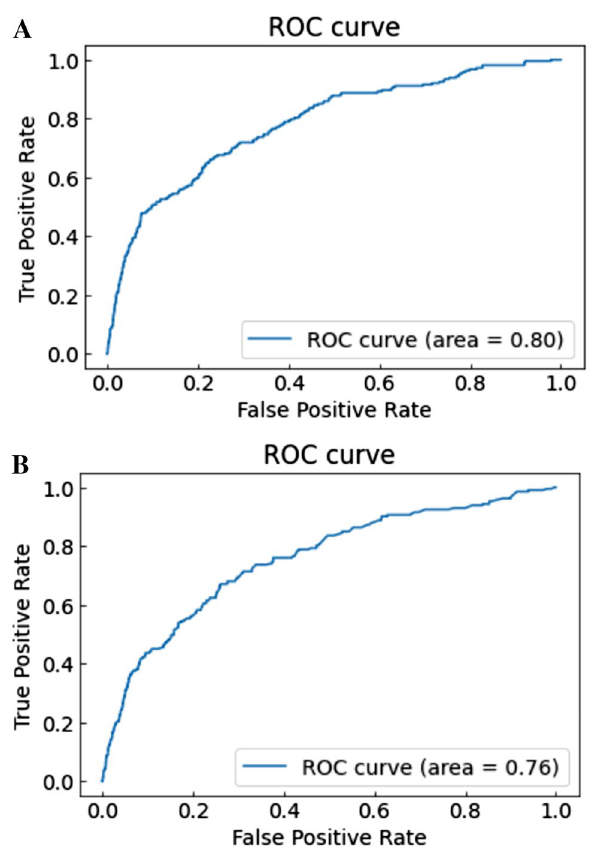
Figure 5. ( A ) ROC curve with training datasets using the logistic regression model with the 12 NCDR variables. ( B ) ROC curve with testing datasets using the logistic regression model with the 12 NCDR variables. Abbreviations: ROC: receiver operating characteristic.